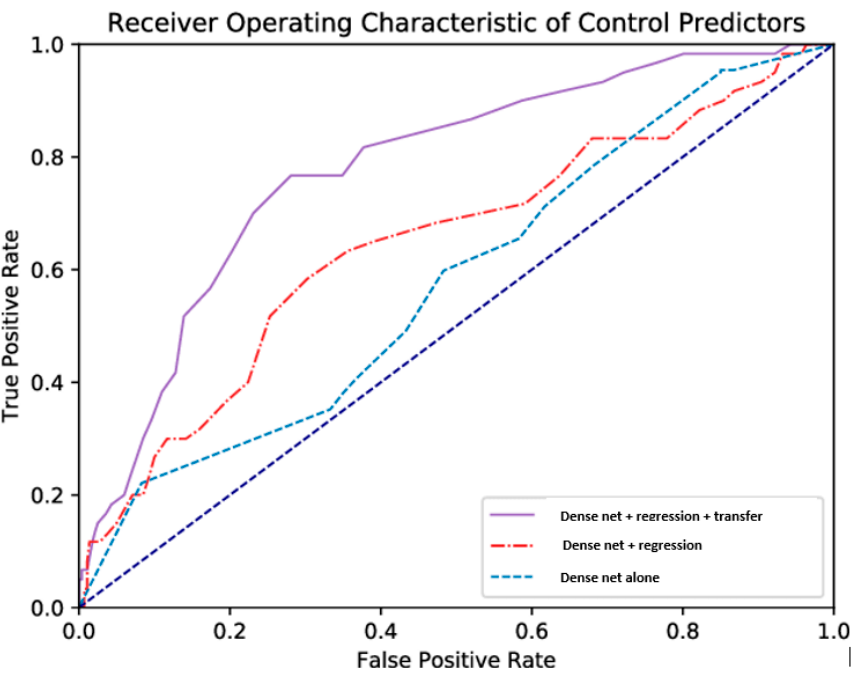
Figure 9. AUC curve for the Dns ‐ Net model with regression inferring the transfer learning effect, the greater the area under the curve the better accuracy.